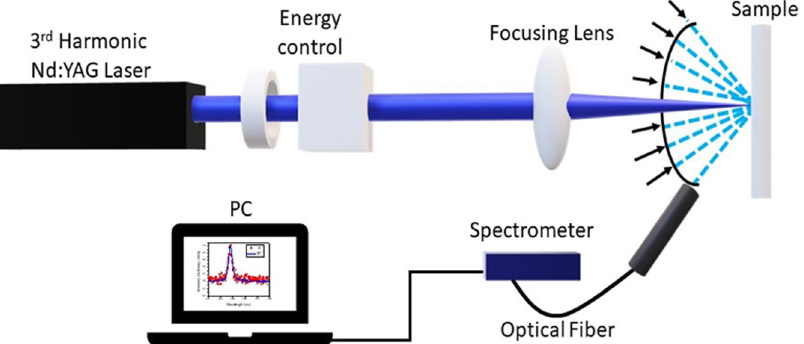
Figure 6. Experimental scheme for ZnO-based optical characterization. The 3rd harmonic of Nd:YAG laser passed through a half-wave plate and a polarizer for energy control. Then it was focused by a 50 cm focal length lens onto the sample surface. The angular distribution of RL emission was measured by changing the optical fiber position as represented by the various arrows close to the sample in the scheme.